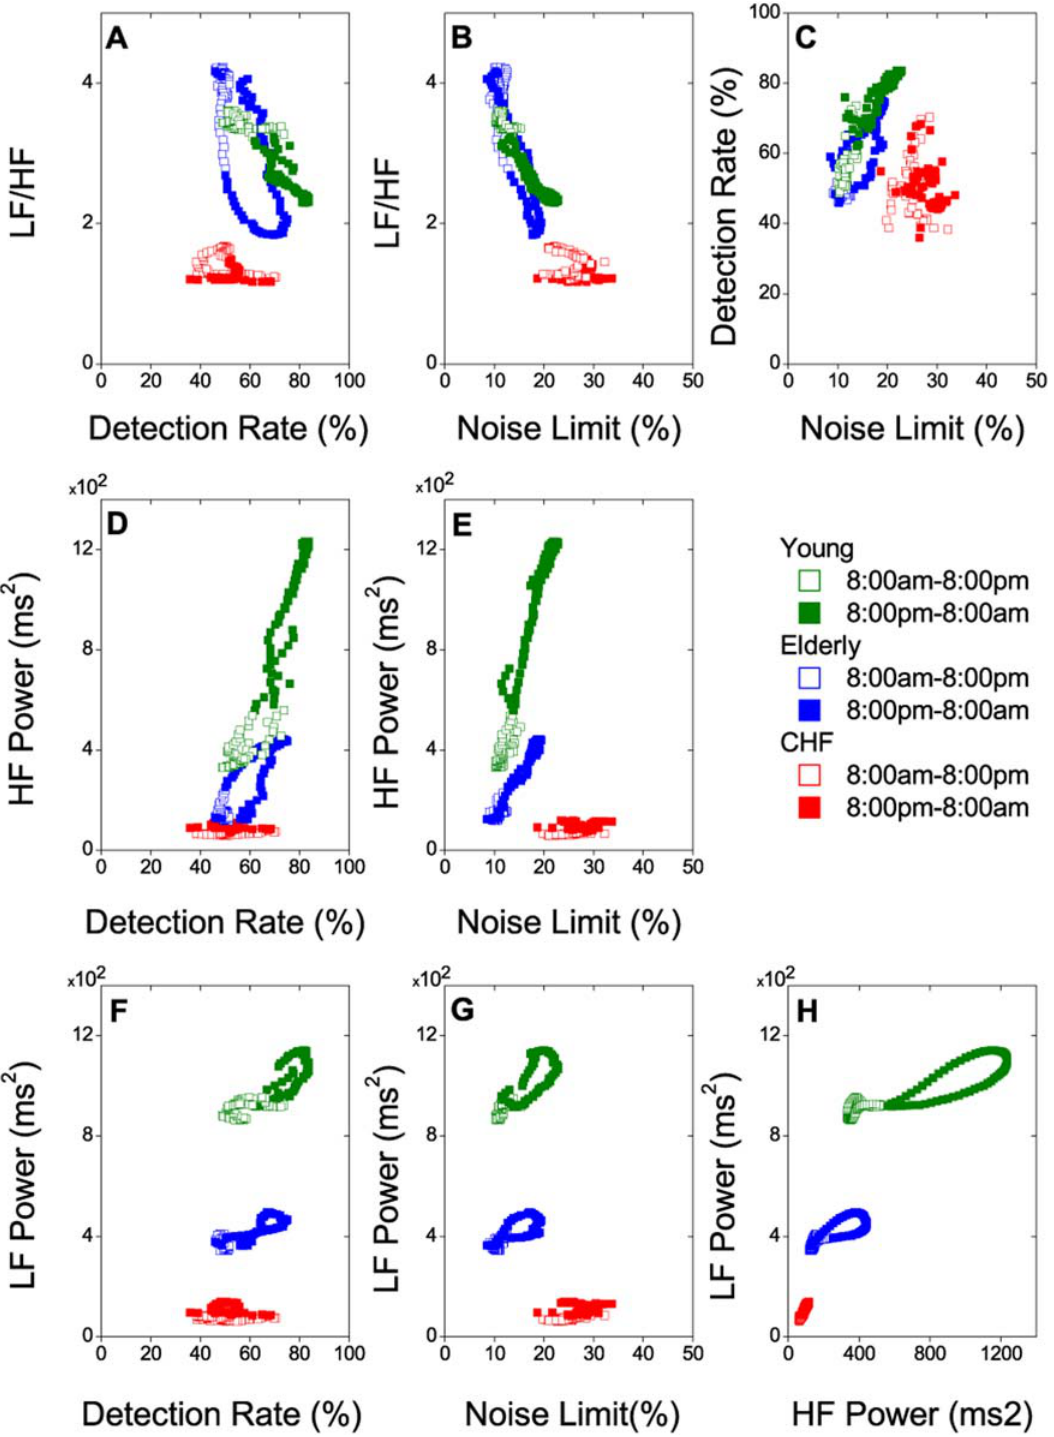
Figure 4. Correlations between chaotic and spectral indices of HRV. Data are average values from each group. Open symbols, daytime; filled symbols, nighttime.